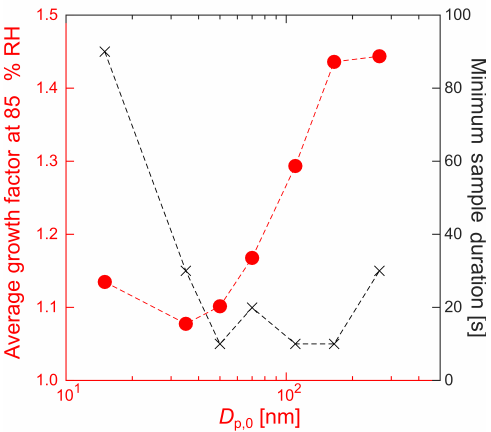
Figure 9. Size-dependent average growth factor at RH = 85% (red circles) and corresponding minimum sample duration (black crosses) of ambient particles sampled on 3 December